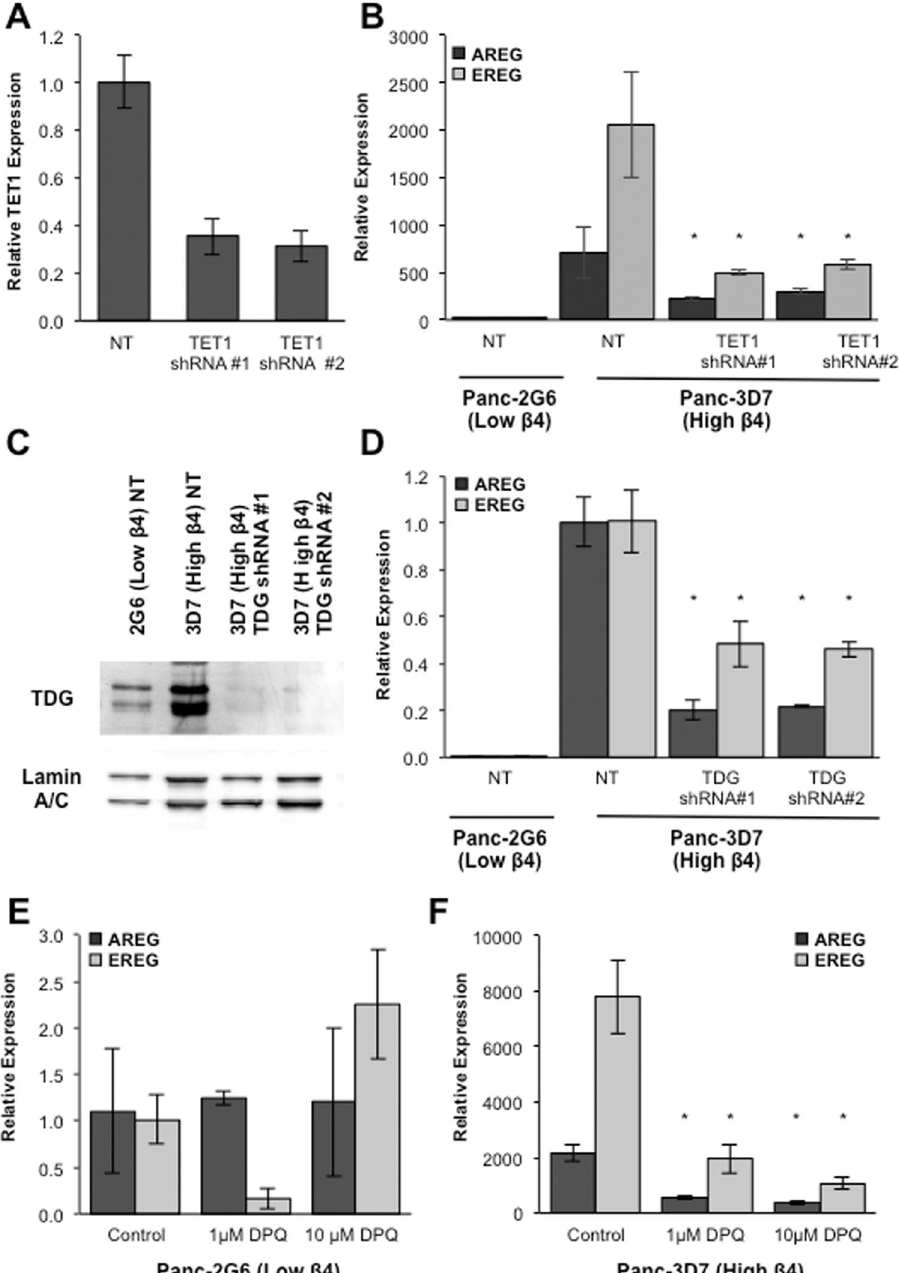
Figure 6. BER is necessary for induction of AREG and EREG expression downstream of integrin α 6 β 4 signaling. ( A , B ) RNA was isolated from Panc1-3D7 cells stably expressing non-targeting or shRNA specific for TET1. QPCR analysis was used to confirm TET1 knockdown ( A ) and expression of AREG and EREG ( B ). ( C ) Nuclei were isolated from Panc1-2G6, Panc1-3D7, and Panc1-3D7 cells expressing specific lentiviral shRNA for TDG. Western blot analysis was performed on nuclear fractions for TDG and Lamin A/C used as a loading control. ( D ) Cells were collected and AREG and EREG expression measured by QPCR. ( E , F ) Cells were treated with either 1 μ M or 10 μ M 3,4-Dihydro-5-[4-(1-piperidinyl)butoxyl]-1(2 H)-isoquinolinone (DPQ) for 72 hours. Expression of AREG and EREG was measured by QPCR in Panc-2G6 (low α 6 β 4; E ) and Panc-3D7 (high α 6 β 4; F ) cell lines. Data depicted are representative of at least three different experiments and represent the mean + / − standard deviation. Statistical significance was calculated using a one-tailed t-test in which * denotes P < 0.05 as compared to